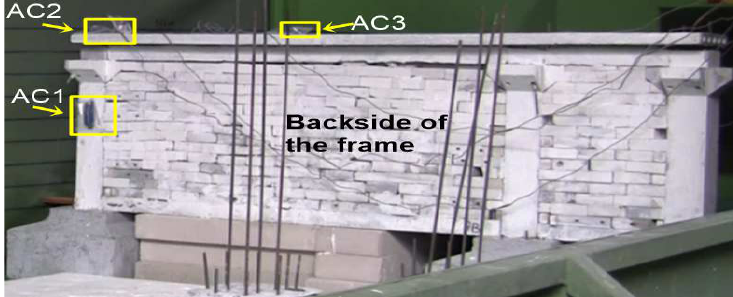
Figure 21. Illustrating the positions of the accelerometers of the height of the frame. The maximum accelerations, which were recorded using three different accelerom- eters during the tests, were analyzed using seismosignal to understand the frame struc- ture’s behavior. During the third dam-break test of the IBS frame, the accelerometers recorded the highest acceleration due to the high impact of hydrodynamic forces against the structure. Table 13 presents the results of the maximum acceleration for the 2D frame. Table 13. Peak values of accelerations for the IBS frame.